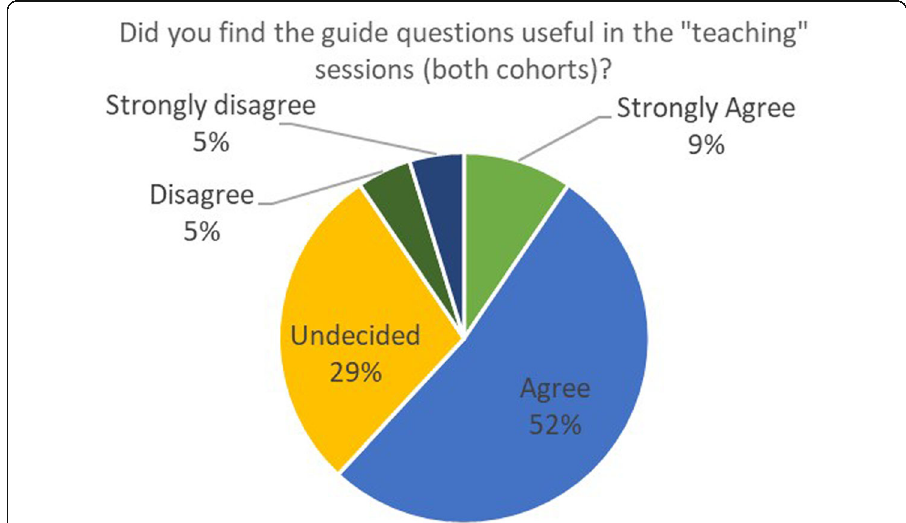
Fig. 2 2017/2018 students ’ feedback on the use of guide